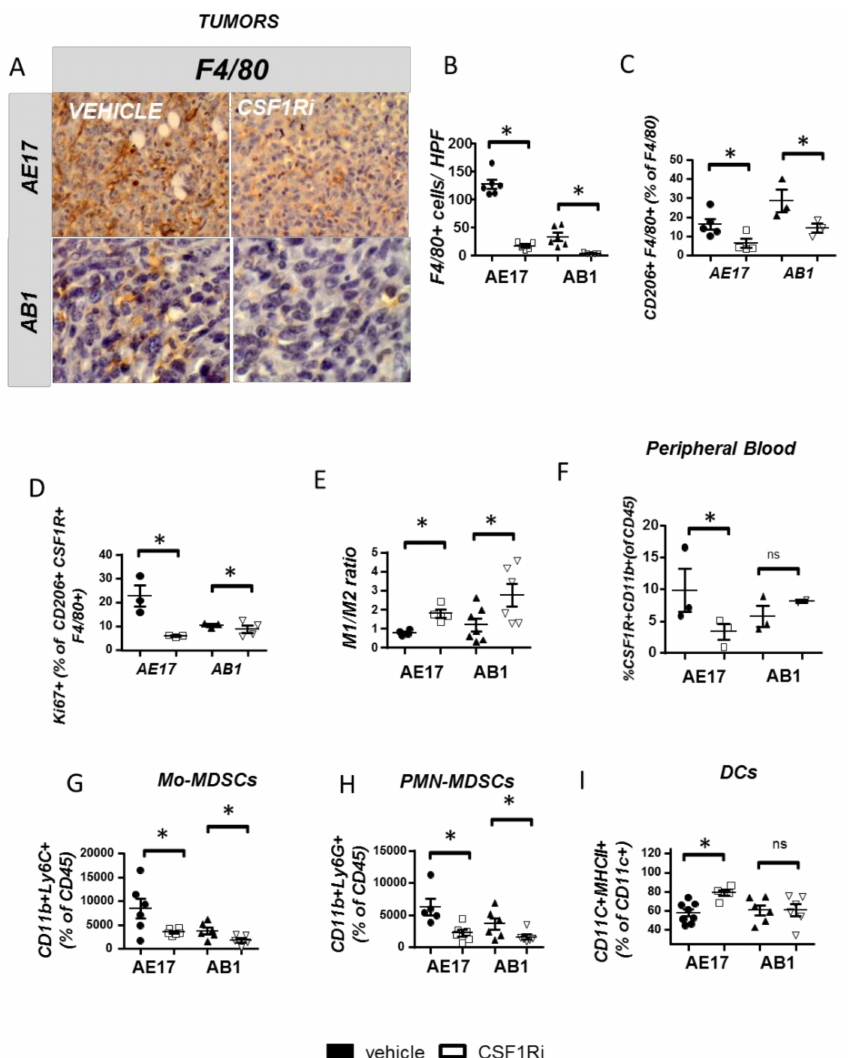
Figure 2. CSF1R inhibition reduces myeloid cell infiltration of mesothelioma tumors, reprograms TAMs towards an anti-tumor profile and boosts DC activation. Tumor tissue sections from vehicle- or CSF1Ri-treated animals were stained for F4/80, and macrophages were counted. ( A ) Representative pictures and ( B ) results of immunohistochemical staining analysis. Data presented as mean ± SEM, n = 5–6 from two independent experiments, * p < 0.05 compared to the vehicle by 2-tailed students’ t -test. HPF: High Power Field. ( C – I ) Tumors of vehicle- and CSF1Ri-treated animals were analyzed for major CSF1R-expressing myeloid populations using flow cytometry. ( C ) CD206+ M2 populations were quantified in tumors of vehicle- and CSF1Ri-treated mice. ( D ) M2 TAM proliferation was quantified. ( E ) TAM IL12/IL10 expression ratio (indicative of M1/M2 polarization) was determined. ( F ) Circulating CSF1R+n monocytes (CD11b+/CD45+) were quantified in the peripheral blood. ( G , H ) Tumor infiltration of myeloid-derived suppressor cells. ( I ) Activation (MHCII+) of tumor dendritic cells (CD11c+) was determined. Data are presented as mean ± SEM, n = 5–8 from two independent experiments, * p < 0.05 compared to the vehicle by 2-tailed students’ t -test. ns = not